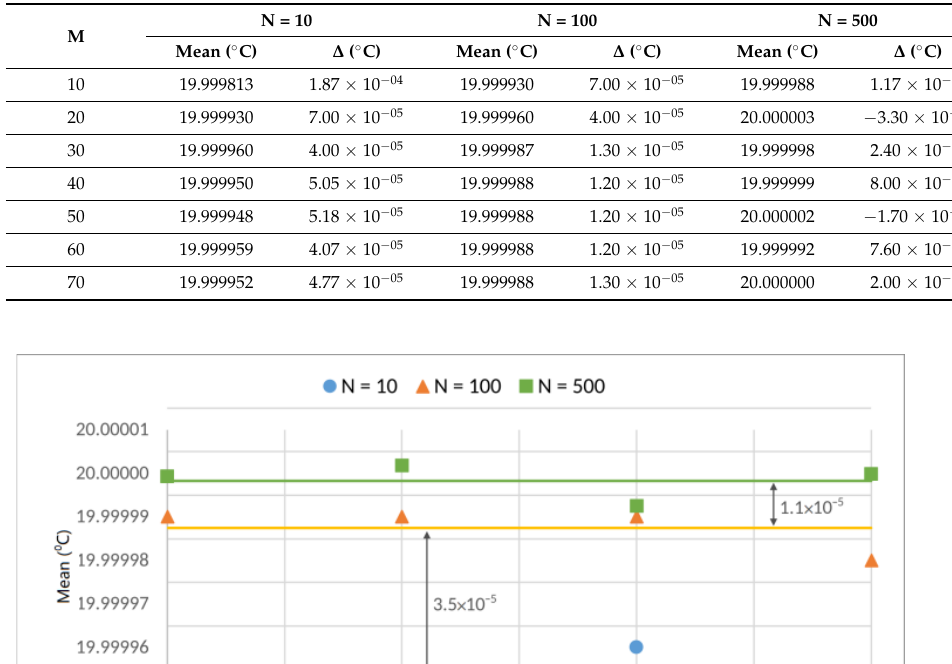
Table 1. Asymptotic Behavior with Increasing M .